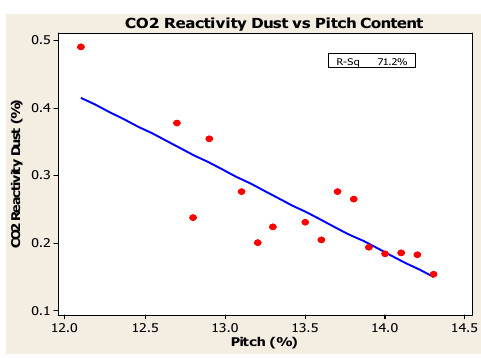
Figure 6. CO 2 reactivity dust vs. pitch.